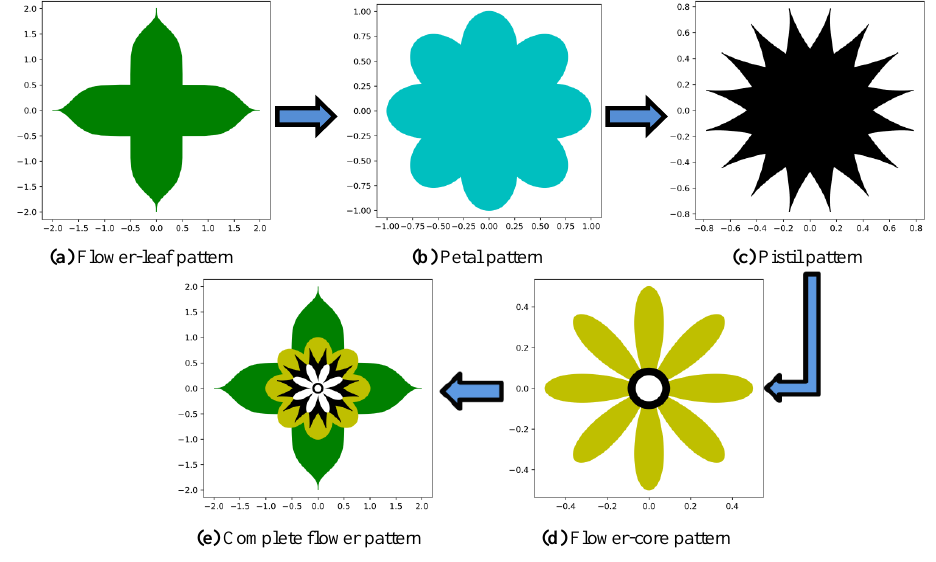
Figure 4. Flower pattern generation process.